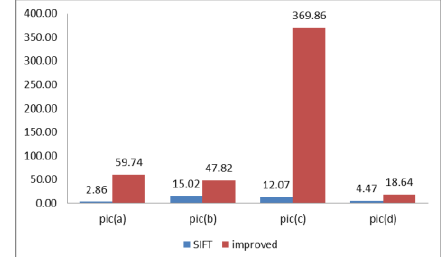
Figure 4(c) speed of matching by SIFT algorithm and improved algorithm. Blue bar for SIFT algorithm and red bar for zero- crossing algorithm. The x-axis showed different group of test images and the y-axis stands for the number of result